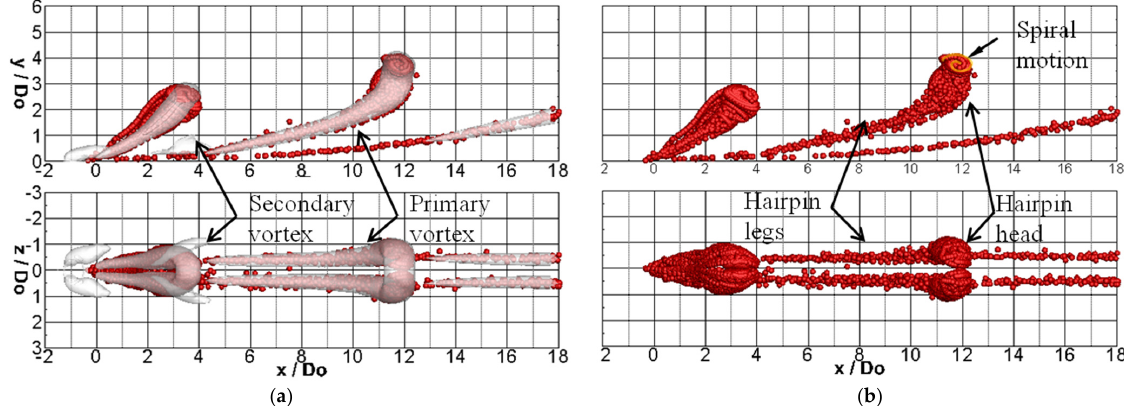
Figure 5. ( a ) Fluid particles plus Q = 5 iso-surfaces and ( b ) fluid particles for a single SJ at t / T =